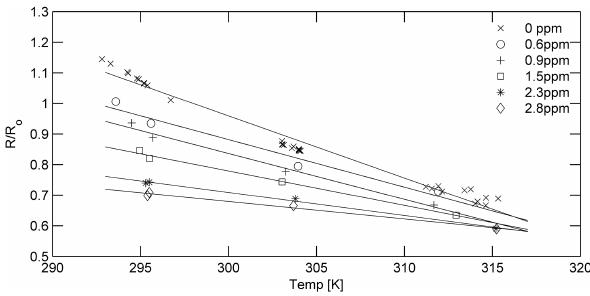
Figure 2. MiCS-5525 CO sensor response to various CO concen- trations while held at different ambient